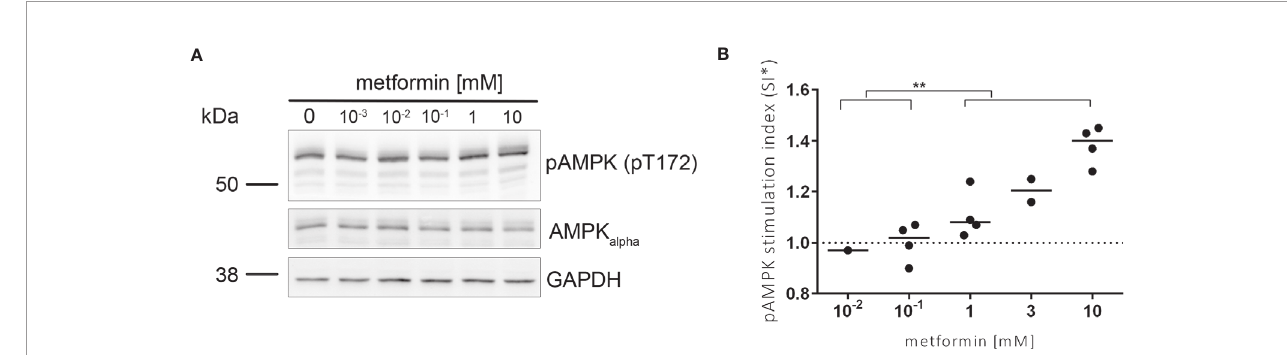
FIGURE 1 | AMPK is activated in a dose dependent manner by metformin. (A) Representative image of the protein amount of pAMPK (pT172), AMPKalpha and GAPDH analysed in lysates of PBMCs stimulated for 3 h with metformin using speci fi c antibodies by immunoblot analysis. pAMPK (pT172) and AMPKalpha are run on two separate gels in parallel each with GAPDH as control. (B) Activating phosphorylation of AMPK was quanti fi ed using Image J (NIH). The median stimulation index (SI, treated/untreated) is shown for the pAMPK/AMPKalpha ratio normalized to unstimulated control. Signi fi cance was calculated with the Mann-Whitney test between indicated groups. **P ≤